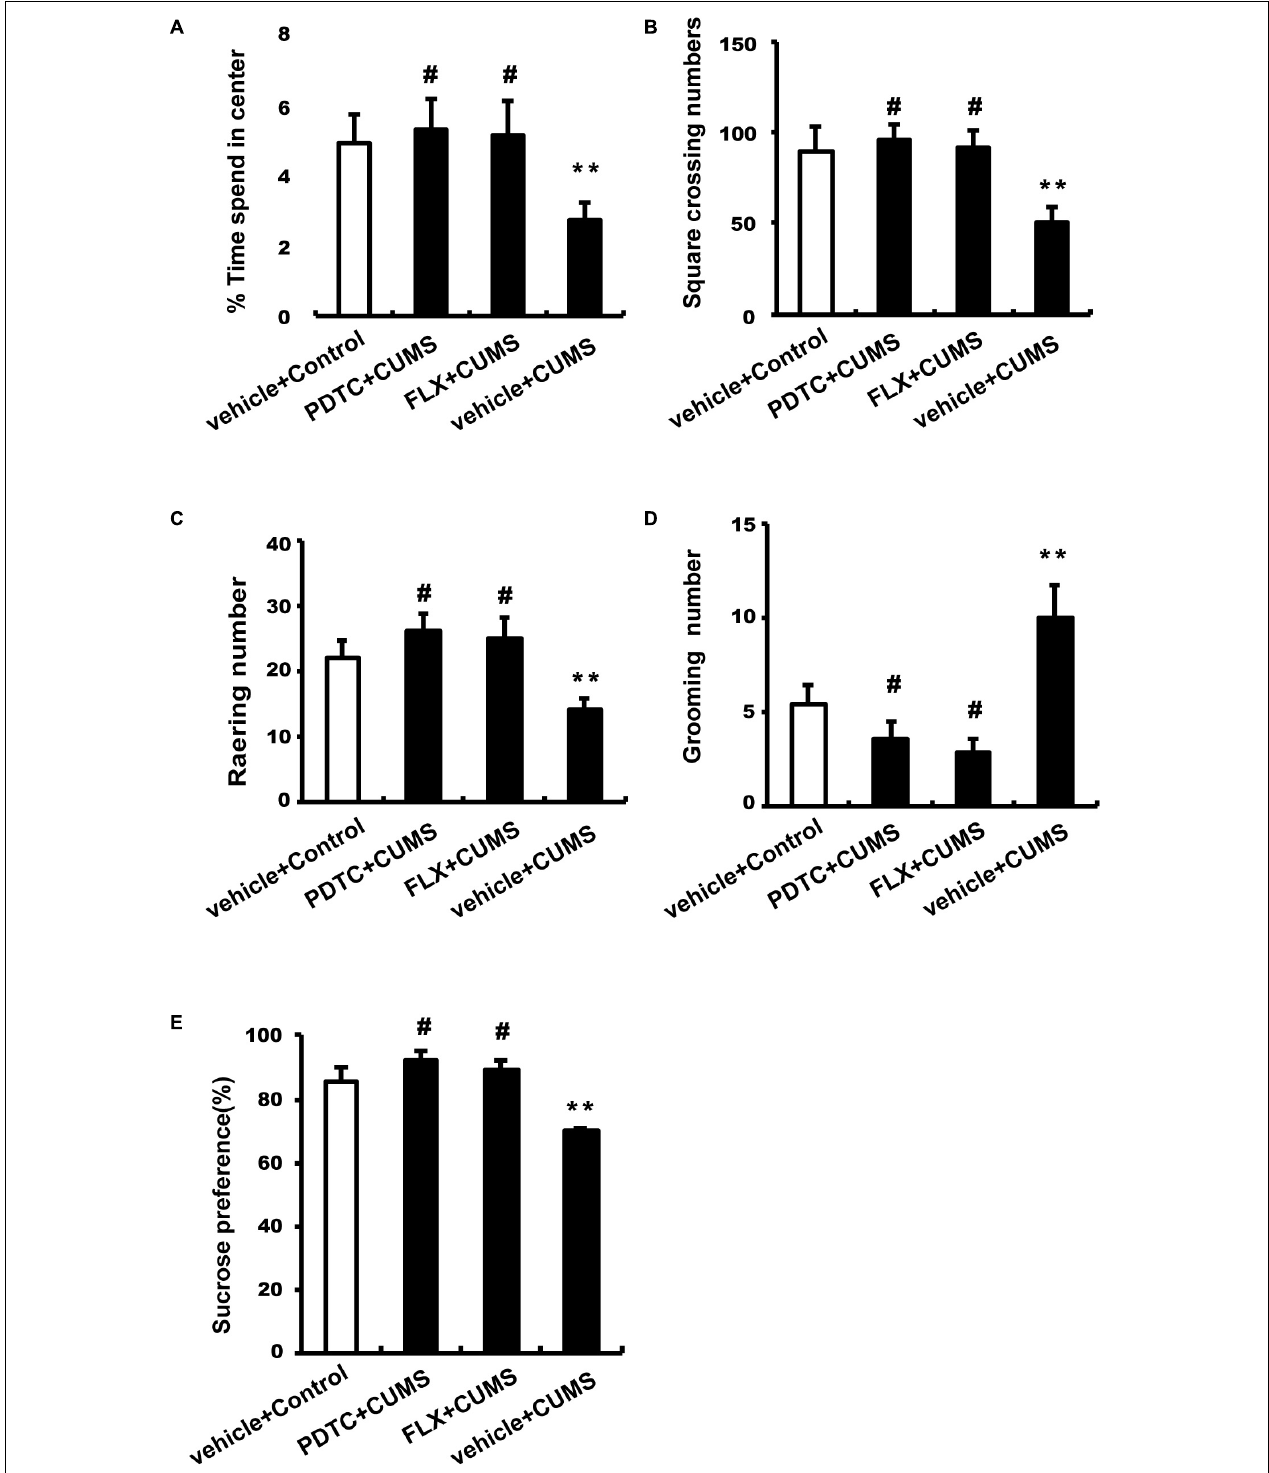
FIGURE 2 | Administration of PDTC and fluoxetine reversed CUMS-induced depression-and anxiety-like behaviors in rats. After CUMS treatment, all rats were subjected to OFT and SPT. Compared to the CUMS group, both PDTC and fluoxetine pretreatment reversed CUMS-induced decrease in the time spent in the center (A) , square-crossing number (B) , and rearing number (C) and increase in grooming number (D) . In SPT, the sucrose consumption of CUMS rats decreased significantly, which could be rescued by PDTC or fluoxetine pretreatment (E) . All values are presented as mean ± SEM. n = 10 and ∗∗ p < 0.01 versus the control group. # p < 0.05 versus the CUMS group. FLX,